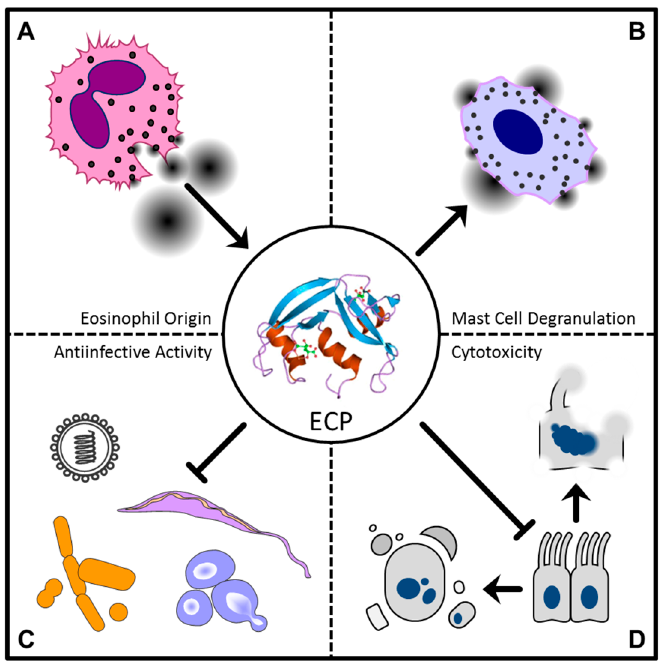
Figure 2. Effects of the eosinophil cationic protein (ECP). ( A ) ECP is stored in the secondary granules of eosinophils and can be released upon eosinophil simulation; ( B ) ECP can induce degranulation of mast cells; ( C ) ECP has broad antimicrobial activity, including inhibition of viruses, Gram-positive and Gram-negative bacteria and fungal and helminthic pathogens; ( D ) dose-dependent cytotoxic effects have been described for ECP, including necrosis and